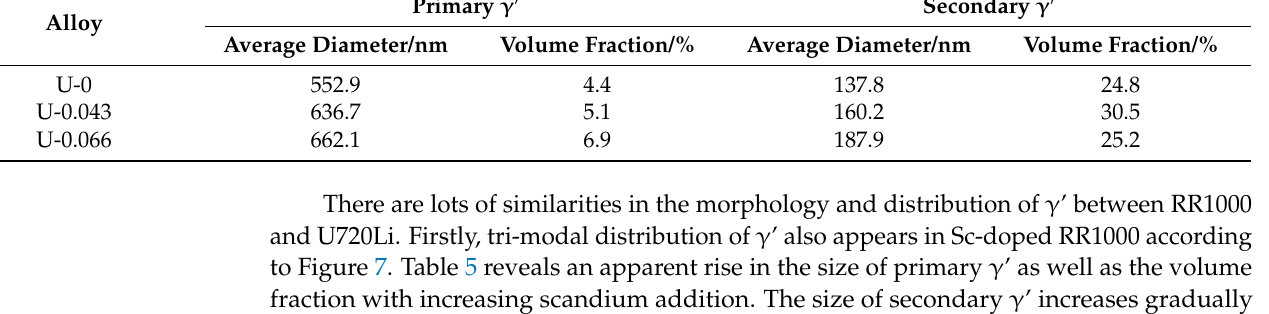
Figure 6. Morphology and distribution of γ ’ in U720Li with di ff erent scandium addition. ( a , d , g ) 0